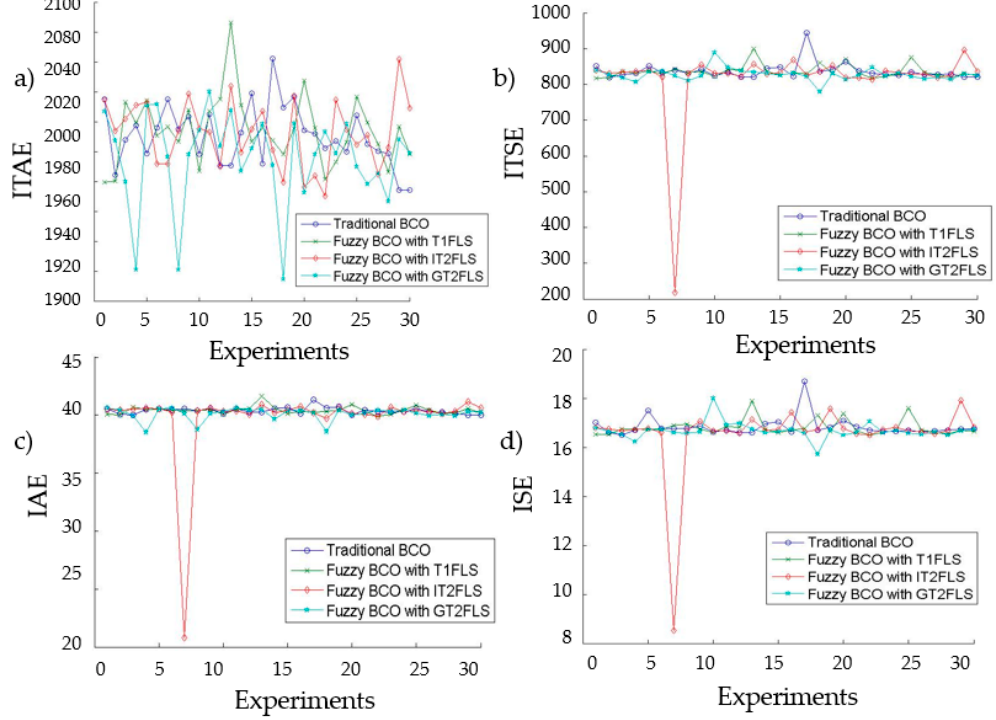
Figure 19. Behavior of various performance indices in relation to band-limited perturbations with value of 1 presents the system, when Fuzzy Bee Colony Optimization-Type-1 Fuzzy Logic System, FBCO-Interval Type-2 Fuzzy Logic System and FBCO-Generalized Type-2 Fuzzy Logic System are used. ( a ) ITAE; ( b ) ITSE; ( c ) IAE; and ( d ) ISE.